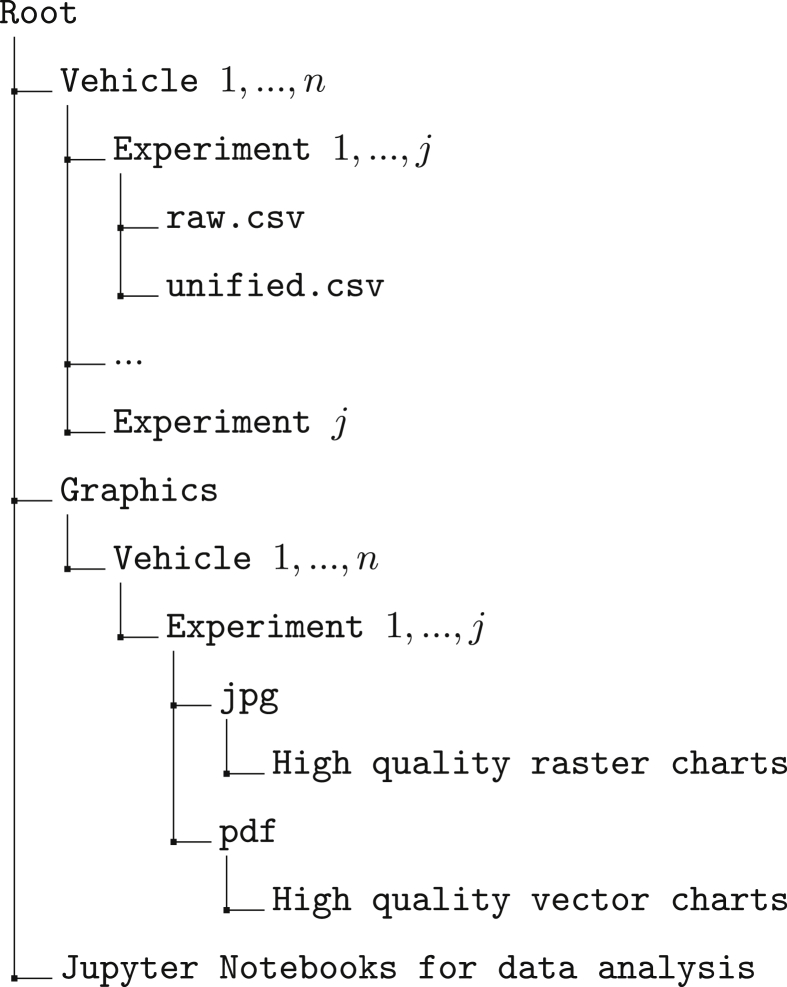
Code repository [2].